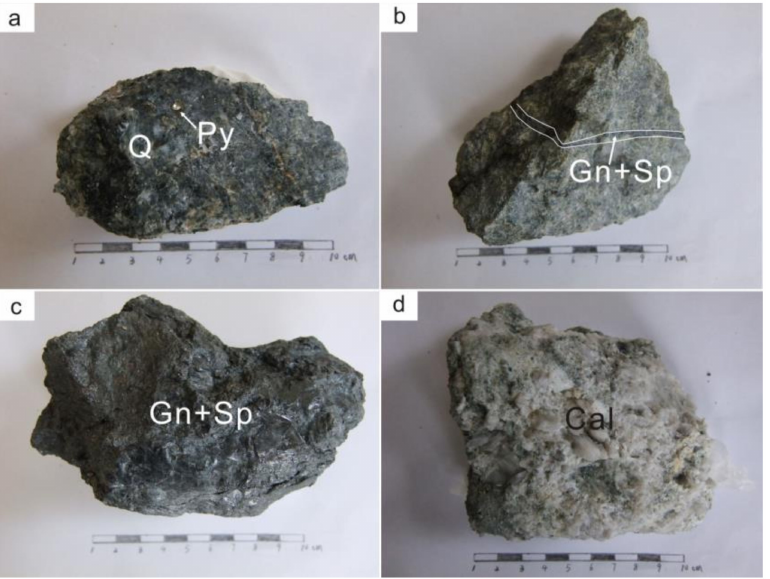
Figure 4. Representative specimens of different metallogenic stages of Yingfang lead-zinc deposit. ( a ) Automorphic pyrite and quartz of Stage I; ( b ) Sphalerite and galena veins cut through the early siliceous rocks of mineralization of Stage II; ( c ) A massive ore of sphalerite and galena of Stages II; ( d ) Carbonate of Stage III.